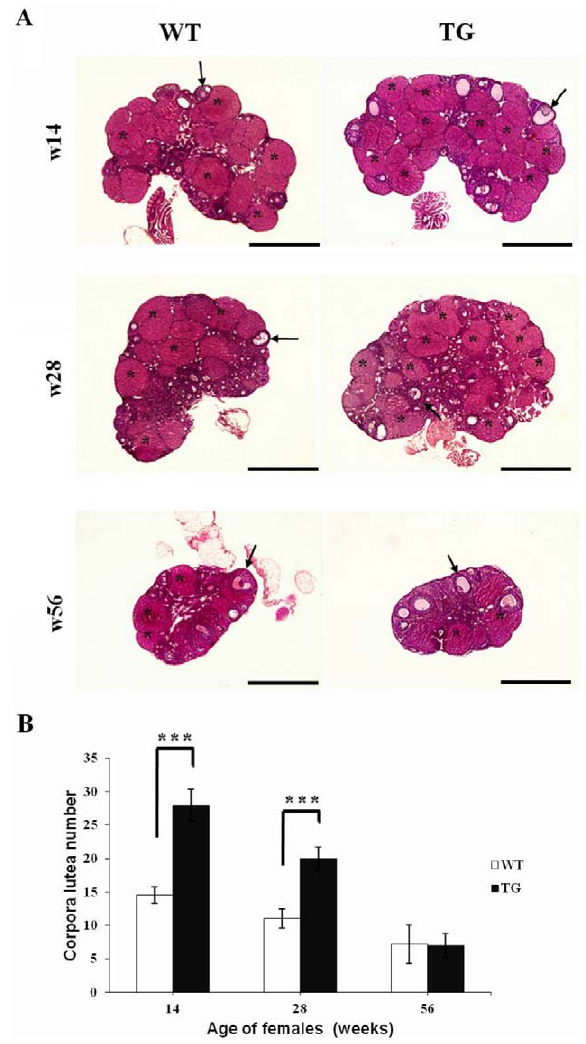
Figure 6. Effects of pFSH a and pFSH b expression on the number of ovarian corpora lutea. (A) Ovarian sections (5 m m) from WT and TG females at 14, 28, and 56 weeks of age were stained with H&E. Antral follicles, arrows; corpora lutea, asterisks; scale bars, 2.0 mm. (B) Total number of ovarian corpora lutea during the diestrous stage of the estrous cycle in TG and WT females at 14, 28, and 56 weeks of age; n =6–8 mice per genotype; *** P , 0.001. The results of the analysis of each of the two separate lines were found to be comparable to that of the combined analysis.